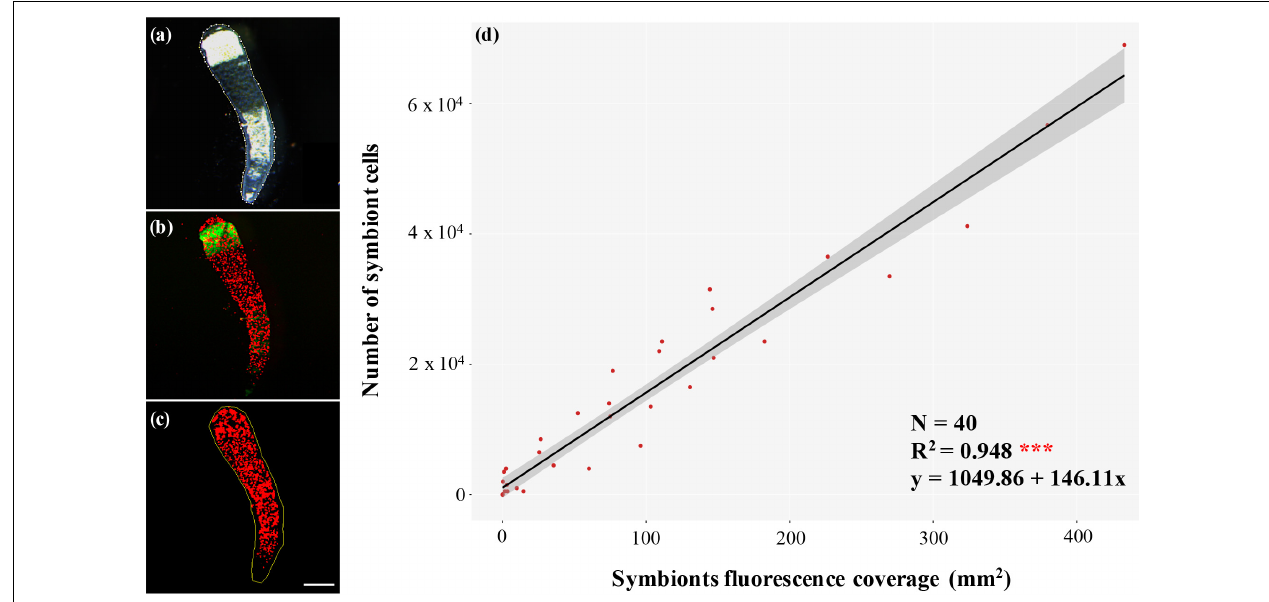
FIGURE 1 | Accurate, non-lethal symbiont quantitation method. (a) Bright field image of a tentacle with region of interest (ROI) selected in FiJi software (dotted white line); (b) fluorescent image of the same tentacle showing algal chlorophyll autofluorescence in red and host autofluorescence in green; (c) superimposition of ROI on the red channel to which a threshold has been applied to score the pixels as either red (symbiont present) or black (symbiont absent), which allows a simple estimate of percentage area colonized, which we show is proportional to the number of symbiont cells per tentacle in panel (d) ; scale bar 250 µ m; (d) calibration curve of the number of symbiont cells and the corresponding fluorescent area occupied within single tentacles from N = 40 anemones at 2, 5, 7, 9, 12, 15, 19, 22, 25, 30 dpi and a permanently symbiotic anemone with the homologous alga B. minutum . The two values correlate significantly ( R 2 = 0.948), and the resulting equation has been used to obtain symbiont density from the measured autofluorescence